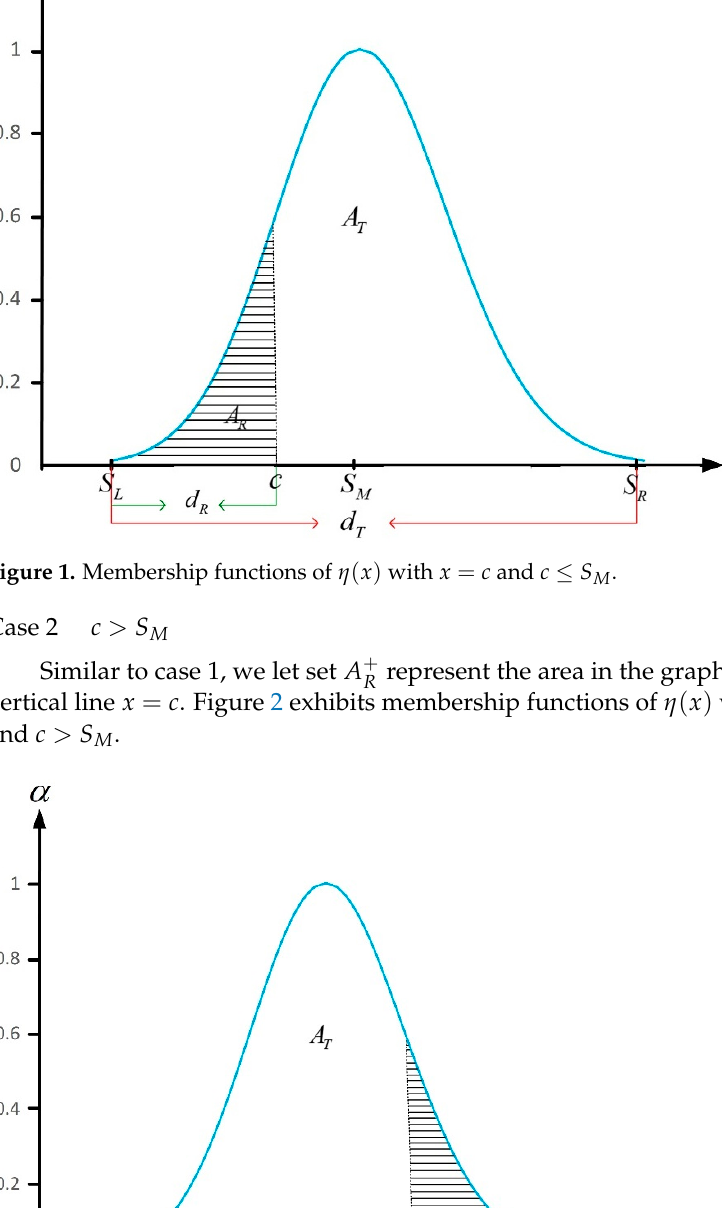
with vertical line